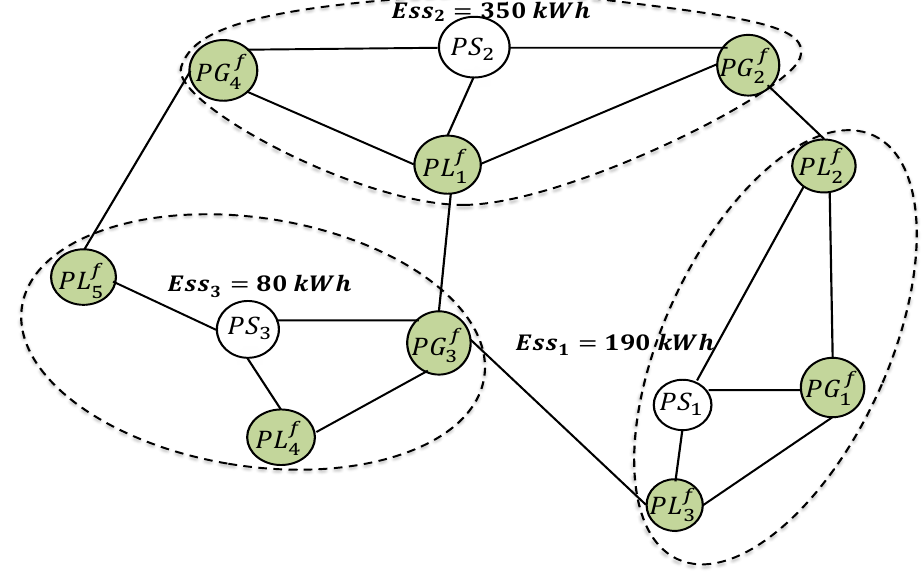
Figure 25. Second possible localization. In the last configuration shown in Figure 26, the location of three power storage devices is changed, and the minimum capacity level of all power storage devices is noticed as Ess 1 = 200 kWh, Ess 2 = 70 kWh, and Ess 3 = 250 kWh. The total capacity is computed as Ess = 520